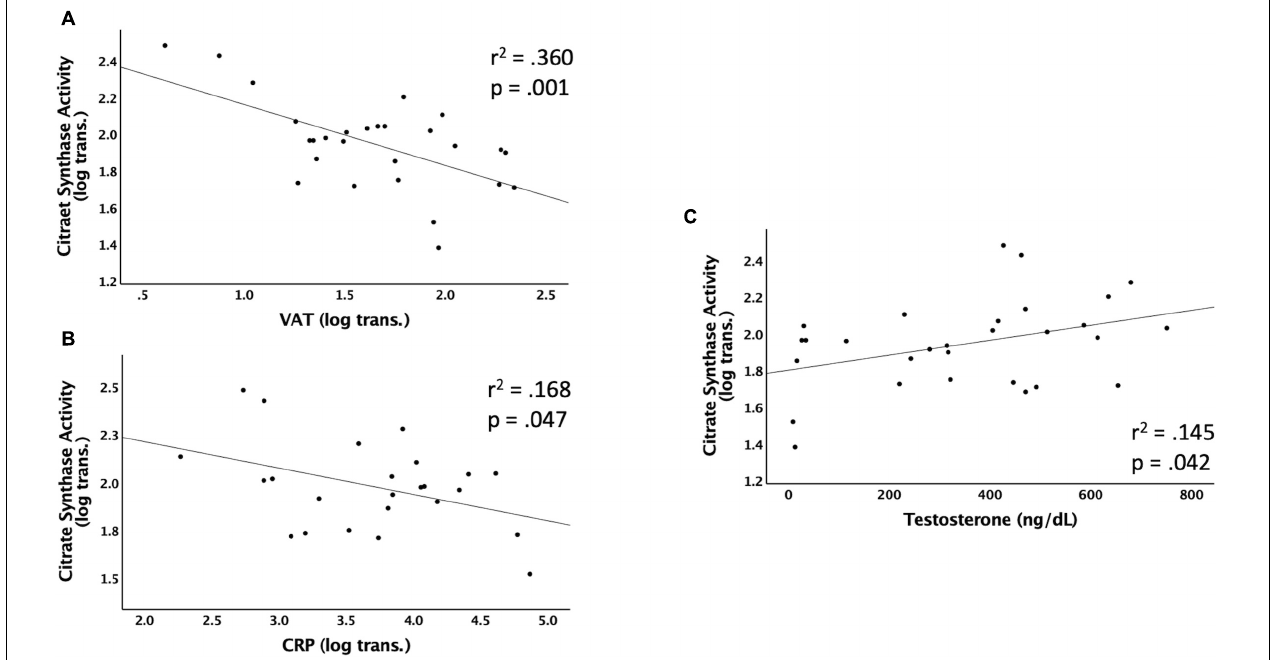
FIGURE 2 | Linear regressions predicting Citrate Synthase (CS) activity. Data that were not normally distributed were log-transformed to permit the use of parametric statistics. The log transformed values of CS enzyme activity are plotted on the Y axis against the predicted values for each variable on the X axis. (A) VAT (log transformed) as a predictor of CS activity, (B) CRP (log transformed) as a predictor of CS activity, (C) testosterone (ng/dL) as a predictor of CS activity. VAT, visceral adipose tissue; CRP, c-reactive protein; ng/dL, nanograms per deciliter.